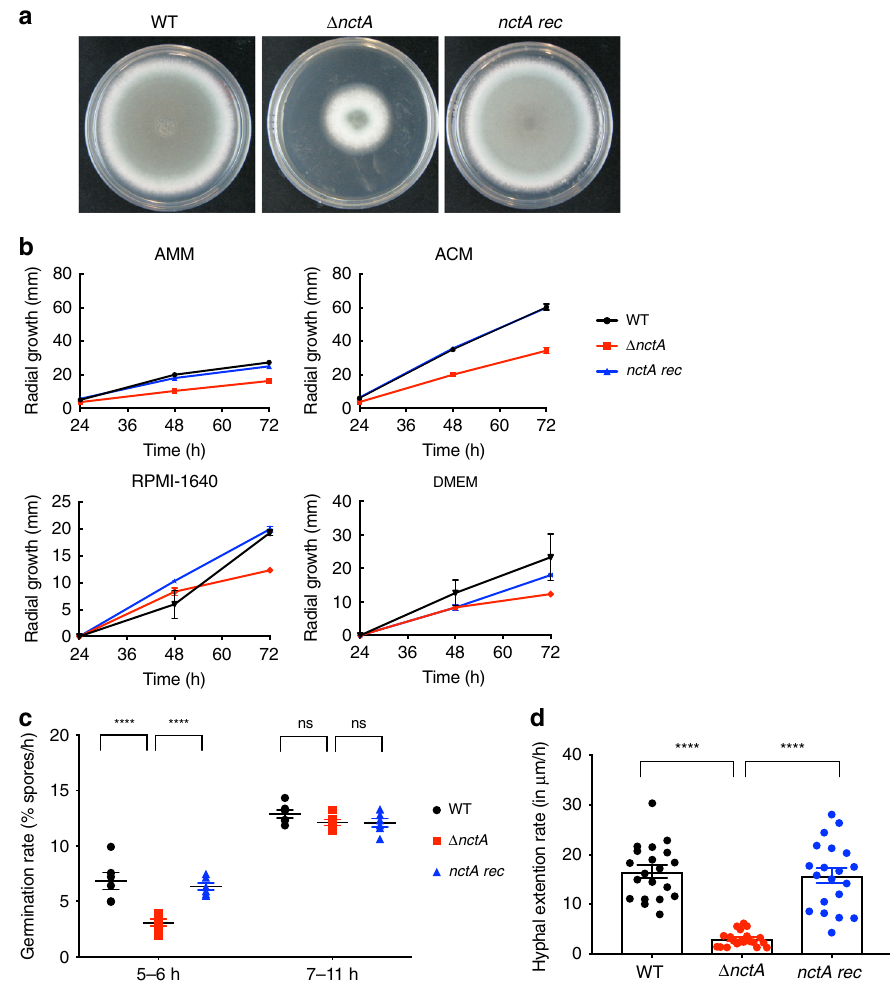
Fig. 2 Impact of nctA deletion upon A. fumigatus growth. a Colonial growth phenotypes of the wild-type MFIG001 (WT), the nctA null ( Δ nctA ) and the nctA reconstituted strain ( nctA rec ) grown on a solid Aspergillus complete medium (ACM) for 72 h at 37 °C. b Radial growth phenotypes on solid ACM, Aspergillus minimal medium (AMM), RPMI-1640 and DMEM. The error bars represent standard error of the mean of three independent experiments. c Germination rates in liquid RPMI-1640 at 37 °C. P -value was calculated by repeated measures two-way ANOVA with Sidaks correction: **** P < 0.0001; NS, P > 0.05. The error bars signify the standard deviations. d Hyphal extension rates in RPMI-1640 at 37 °C. P -value was calculated by Kruskal – Wallis test with Dunn ’ s correction: **** P < 0.0001; NS, P > 0.05. Percentages of germination rates and hyphal extension rates were measured under the microscope. The error bars represent standard error of the mean. Source data are provided as a Source Data fi